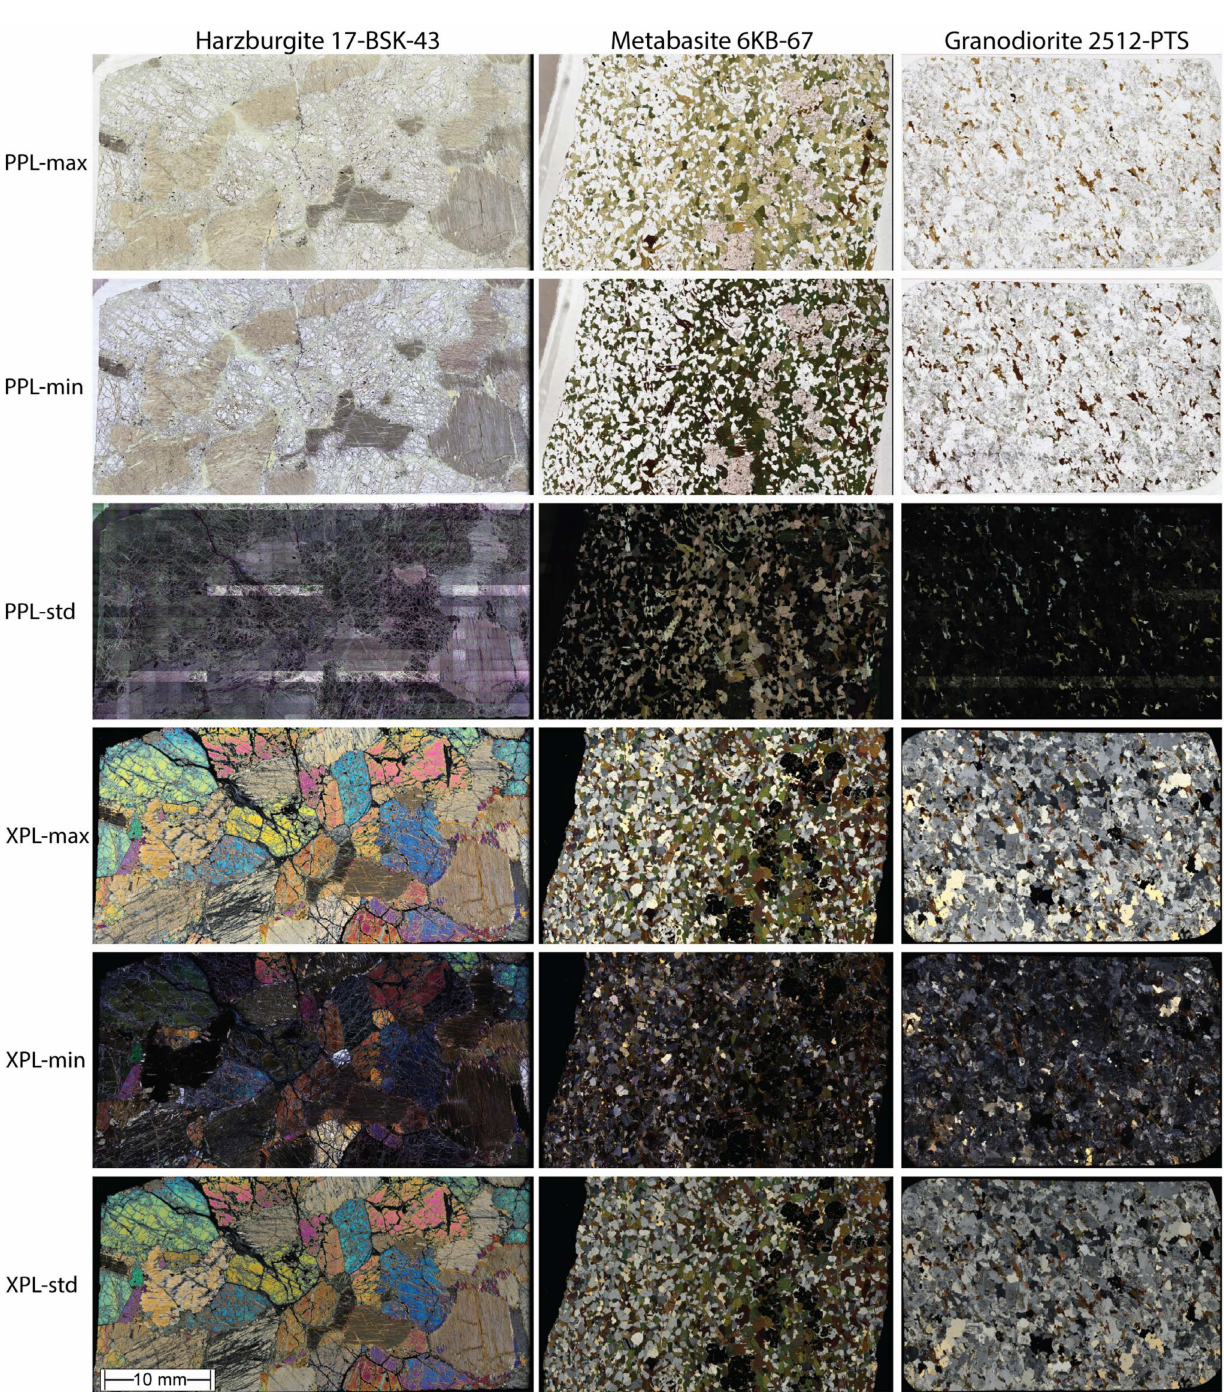
Figure 11. Ray tracing for PPL and XPL whole-slide images in ultra-mafic, mafic, and felsic rocks showing the mutual relationships between mineralogy and statistical measures (maximum, minimum, and standard deviation). The sample names are given at the